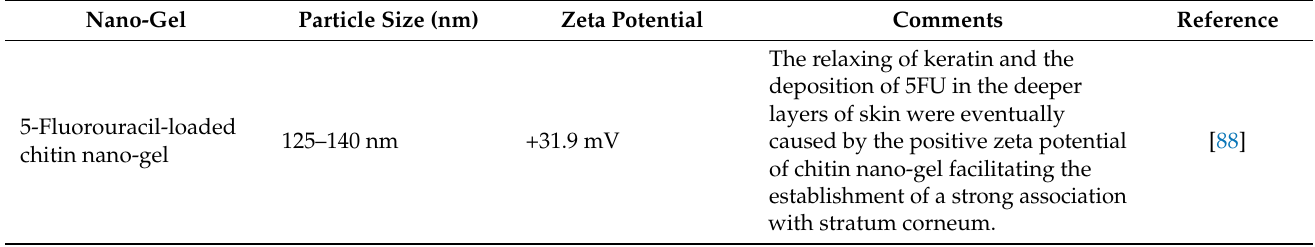
Table 1. Characterization of nano-gels for the management of skin